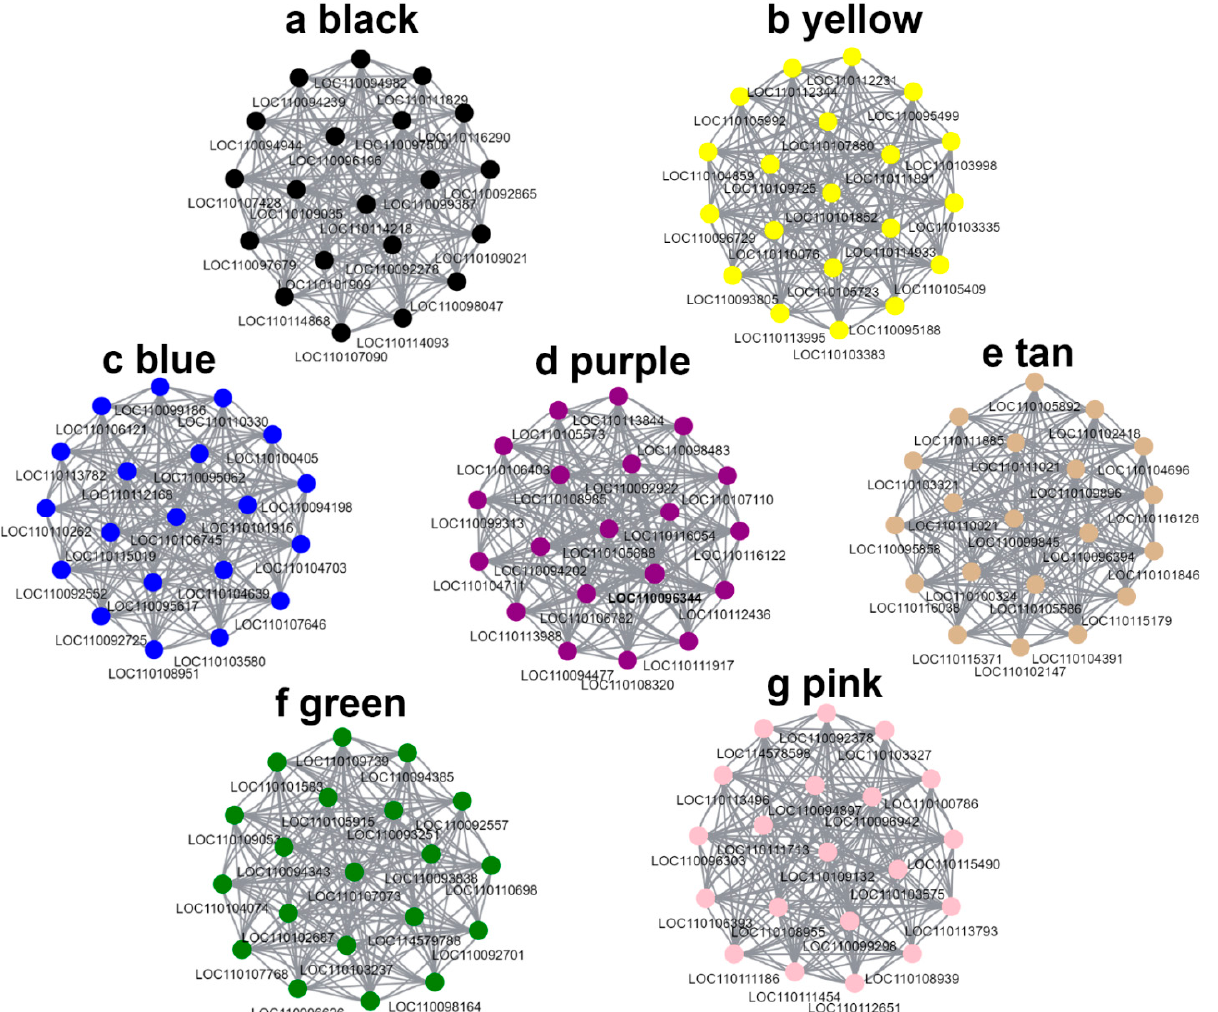
Figure 10. Network diagram of hub genes in 7 modules with high correlation.